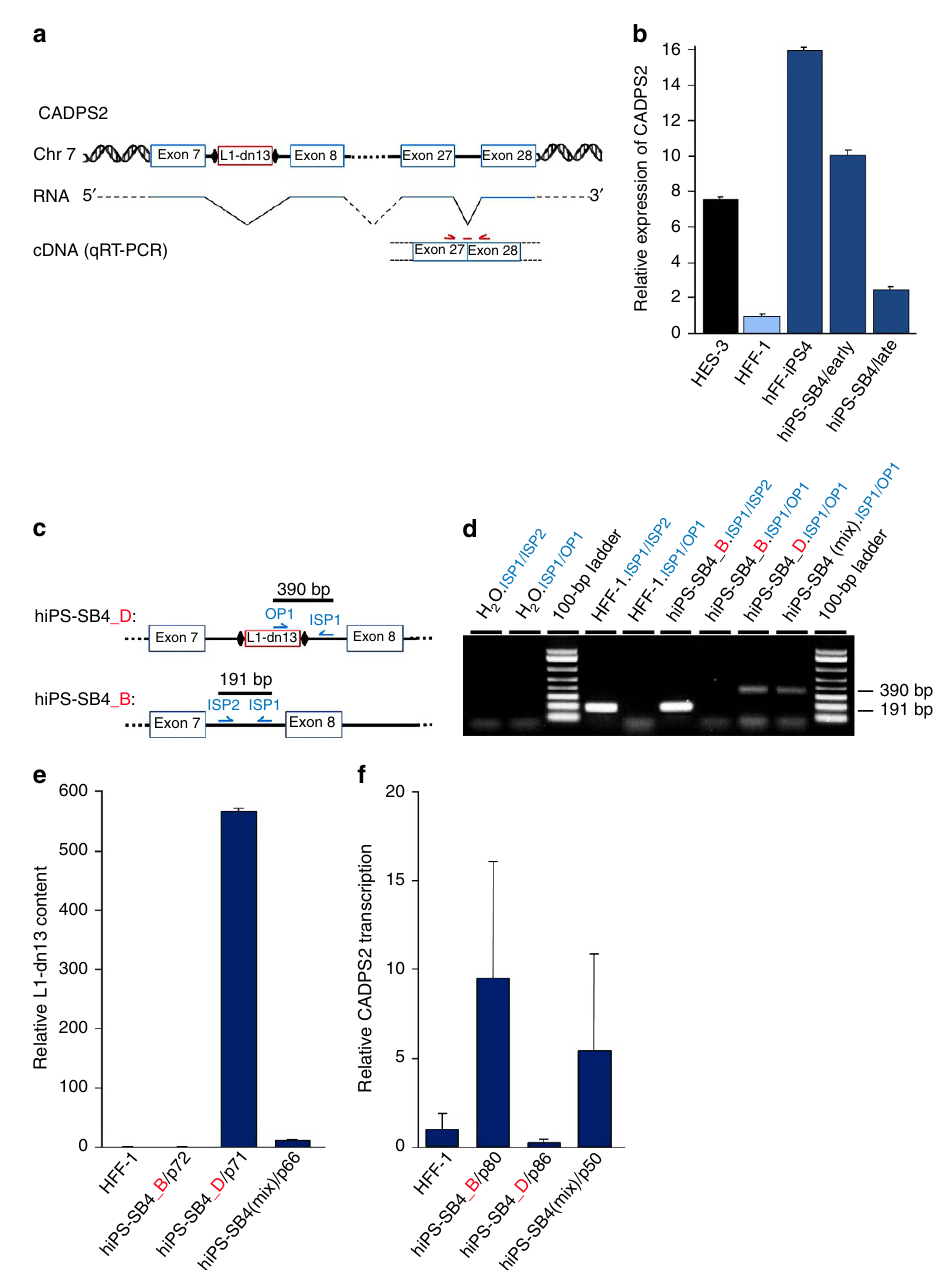
Figure 5 | L1-dn13 affects CADPS2 expression. ( a ) Schematic of the human CADPS2 allele of the hiPS-SB4 line harbouring insertion L1-dn13. A CADPS2 transcript including exons 7, 8, 27 and 28 is presented. Binding sites of the TaqMan primer/probe combination spanning the exon27/exon28 junction on CADPS2 cDNA used for qRT–PCR analysis are shown (red arrows and line). ( b ) Relative CADPS2 mRNA levels in early (p16) and late passage (p50) hiPS-SB4 cells were assessed by qRT–PCR. HES-3 and hFF-iPS4 cells served as positive controls. qRT–PCR results were normalized to 18S rRNA using CADPS2 expression in parental HFF-1 cells as control. Bars, arithmetic means ± s.e.m. of technical triplicates. ( c ) Structure of the L1-dn13 integration site in the CADPS2 gene in hiPS-SB4 subclones. hiPS-SB4_D differs from hiPS-SB4_B by the presence of the L1-dn13 de novo insertion in CADPS2 intron 7. Binding sites of L1-dn13-specific validation PCR primers OP1, ISP1 and ISP2 and expected lengths of the resulting PCR products are indicated. Black diamonds, TSDs. ( d ) Genotyping PCR validating the L1-dn13 presence in subclone hiPS-SB4_D and its absence from hiPS-SB4_B in gDNAs isolated from HFF-1, hiPS_SB4_B, and hiPS_SB4_D cells and from the original mixed population of the hiPS-SB4 culture (hiPS-SB4(Mix)). Primer combinations used are indicated in blue; H 2 O.ISP1/ISP2 and H 2 O.ISP1/OP1, negative control PCRs using H 2 O instead of gDNA; 100-bp ladder, size marker. ( e ) qPCR analyses confirming absence of L1-dn13 from hiPS-SB4_B and HFF-1 cells, and its presence in hiPS-SB4_D cells and the hiPS-SB4 culture. gDNAs from HFF-1 cells and from hiPS-SB4(Mix) cells served as negative and positive controls, respectively. For normalization, a primer/probe combination specific for the human RPP25 gene was used. DD Ct values measured the relative quantity of L1-dn13. Bars, arithmetic means ± s.e.m. of technical triplicates. ( f ) Relative CADPS2 mRNA levels in hiPS-SB4_B, hiPS-SB4_D and hiPS-SB4(Mix) cells were determined by qRT–PCR using cytoplasmic RNA and primer/probe combinations spanning exon 27/exon 28 junction of CADPS2 . Bars, arithmetic means ± s.e.m. of technical